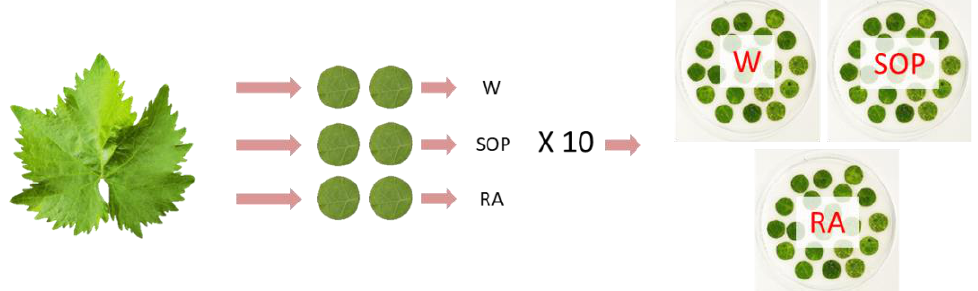
Figure 5. Experimental setup for inhibitory assay. From each leaf, 6 discs were obtained and as- signed in equal number (two) to each of the three treatments: deionized sterile water (W), Salvia officinalis phytocomplex solution 5 g/L (SOP), rosmarinic acid 0.5 g/L (RA). A total of 10 leaves were used, obtaining three plates with 20 discs in each. The experiment was repeated 3 times.